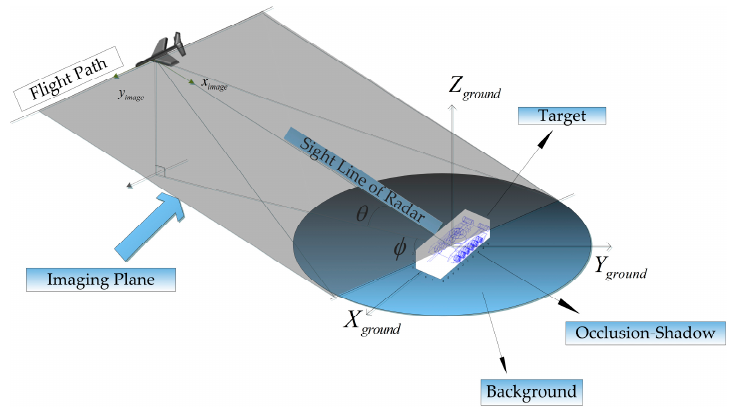
Figure 1. SAR imaging model.